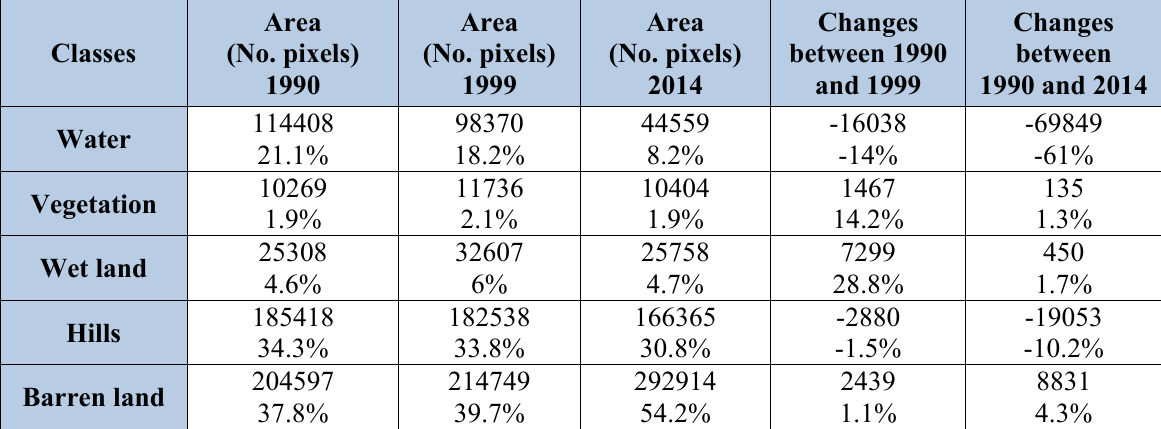
Fig.9: Supervised classification using (SVD) for Landsat-8 (2014). Table 2: The change in the years 1999, 2014 comparing with 1990 using SVD classification method.